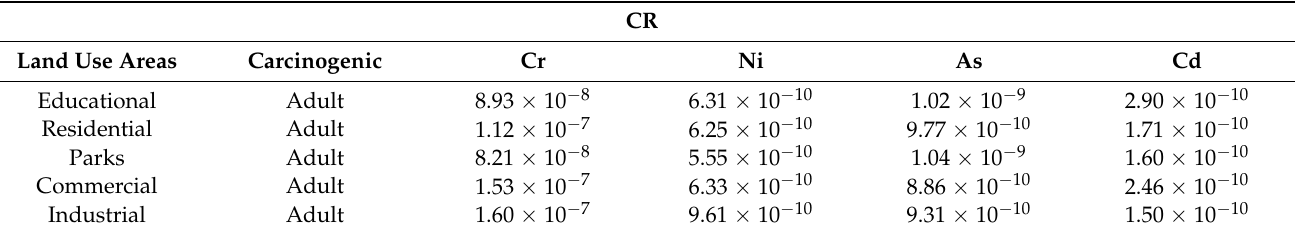
Table 9. Carcinogenic Risk (CR) values of heavy metals in different land use areas.